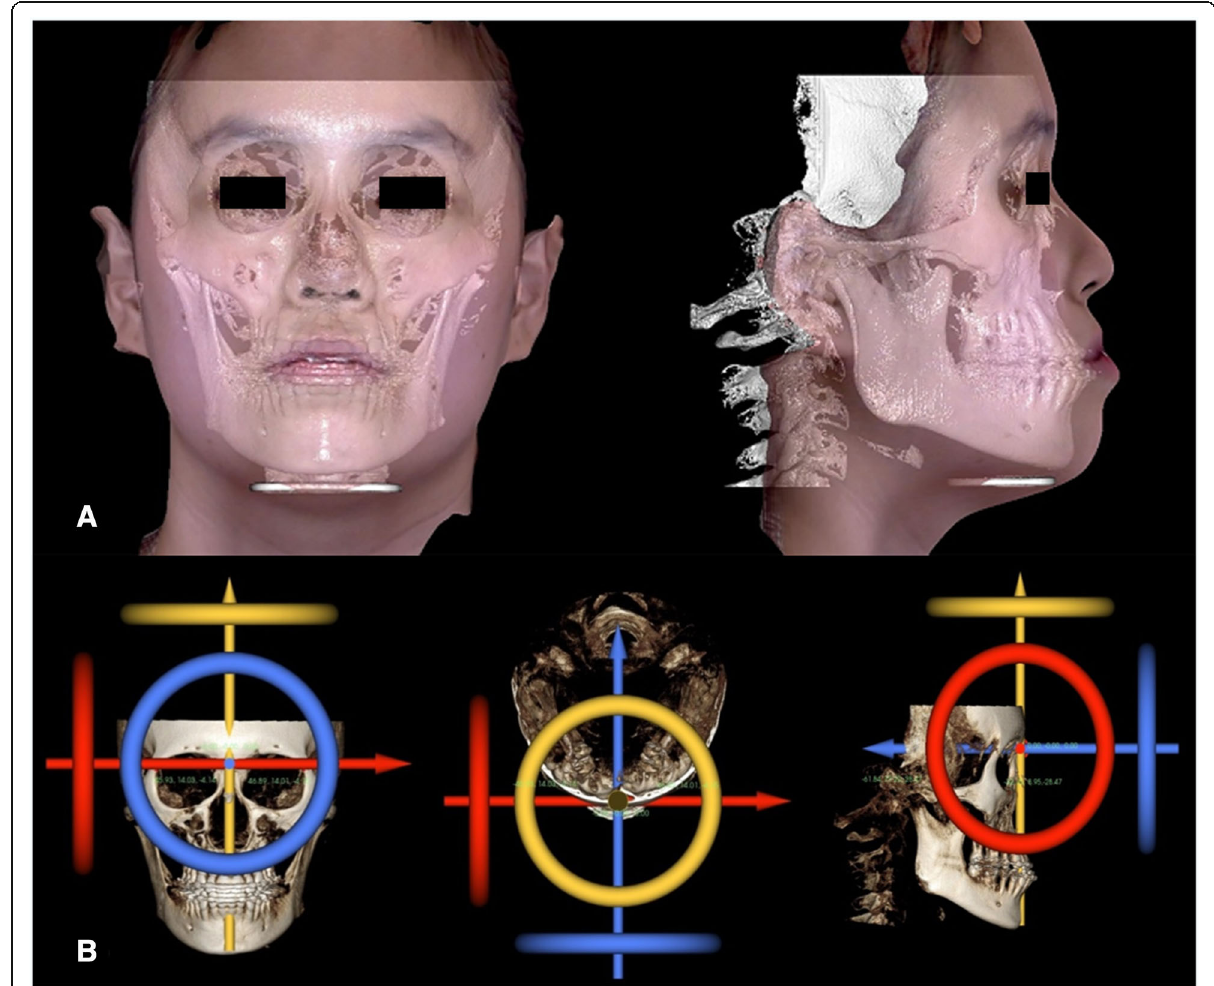
Fig. 1 Superimposed 3D image of CBCT and facial scan ( a ) and 3-dimensional coordinate system ( b